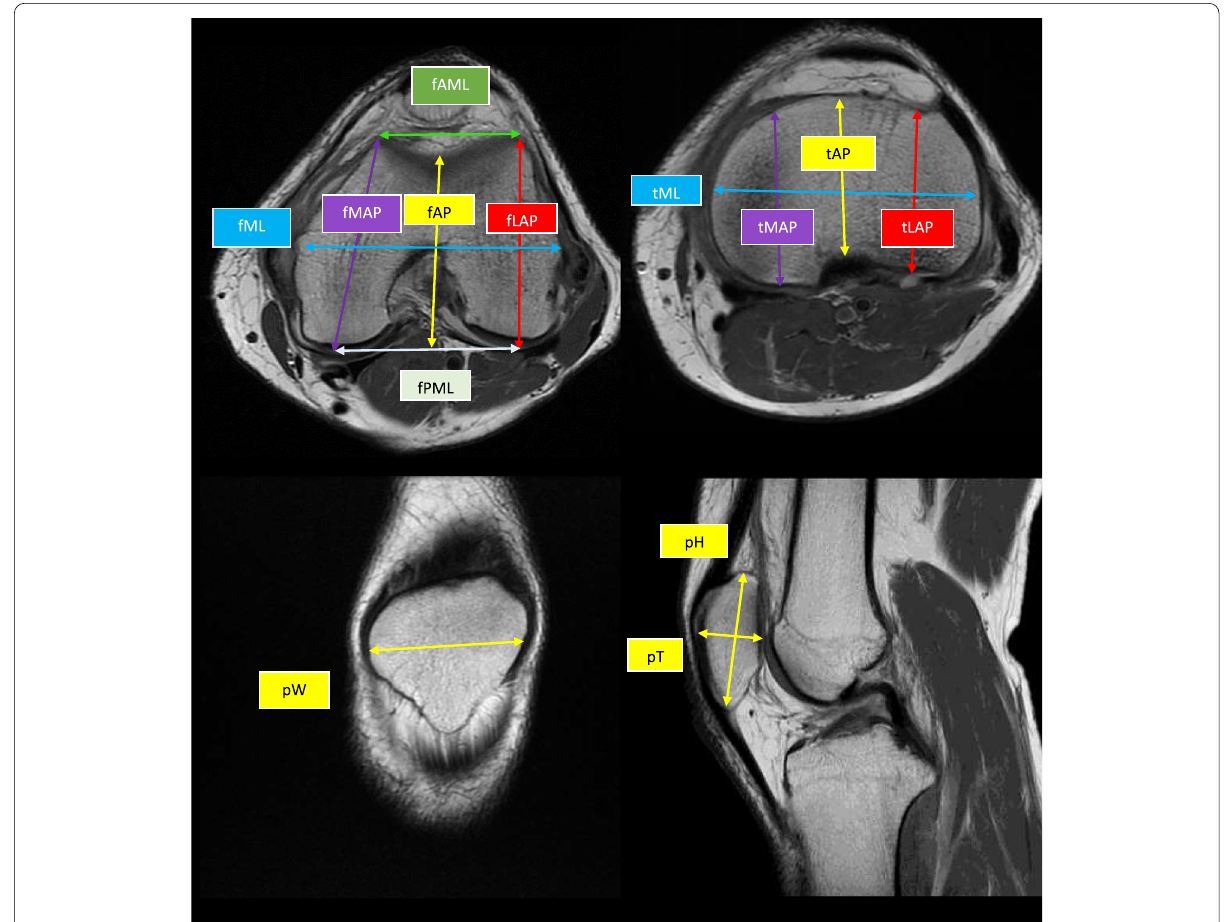
Fig. 1 Morphometric measurements of the